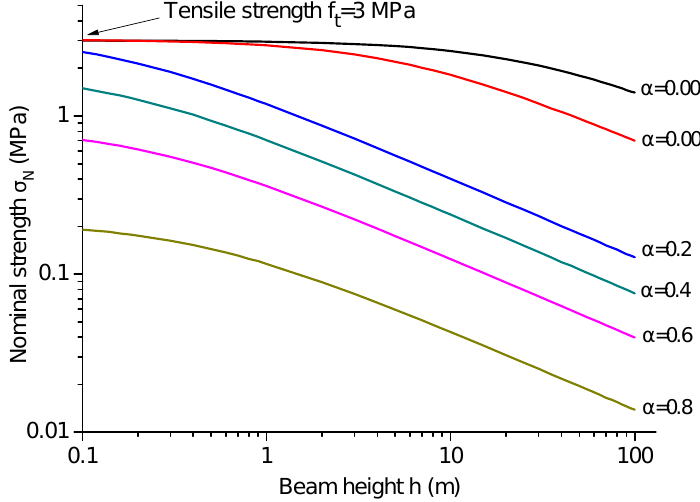
Figure 9. Nominal strengths versus beam height for various crack to height